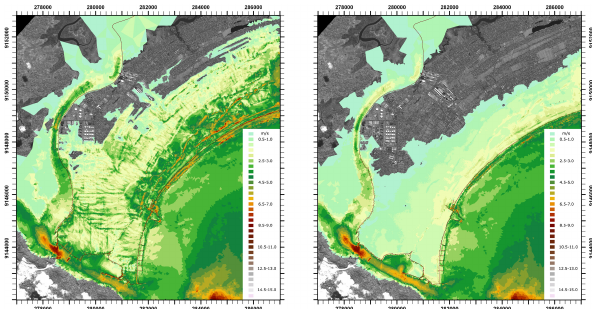
Fig. 8. Sea surface height (seaside) and total water depth (upon land) for a scenario of earthquake magnitude 9 (045 10 mw9.0). Left: with detailed roughness map, right: with constant Manning value M =7.7m 1 / 3 /s everywhere.